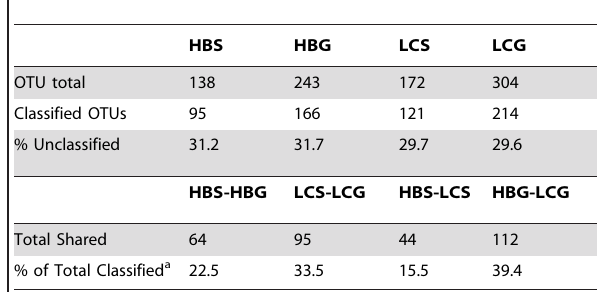
Table 4. Numbers of OTUs observed for Hackberry Bay (HB) and Lake Caillou (LC) stomach and gut (S, G) microbiomes, and numbers of OTUs shared among samples based on sequences classified through the Mothur